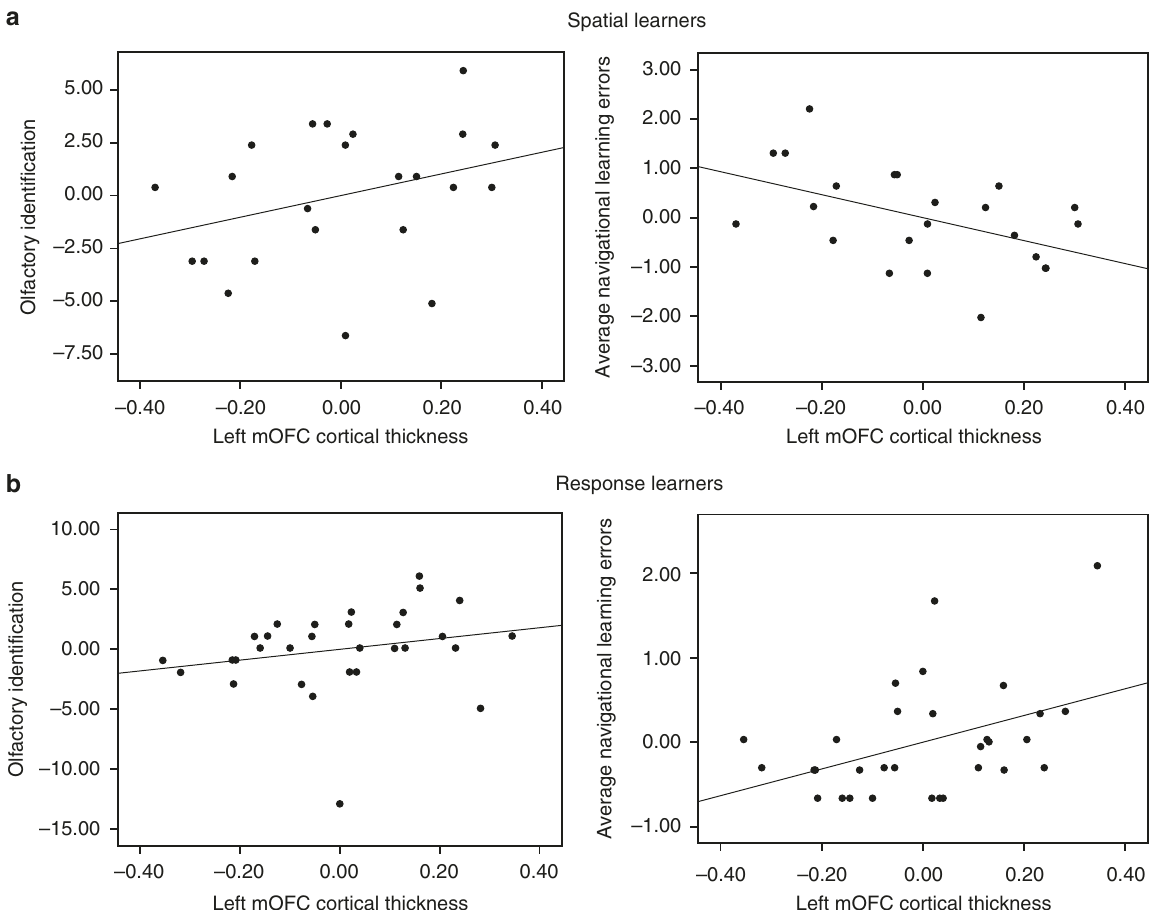
Fig. 3 Left medial orbitofrontal cortex (mOFC) cortical thickness correlates with both olfactory identi fi cation and spatial memory. a We measured mOFC cortical thickness using CIVET. Within spatial learners, left mOFC cortical thickness correlated positively with olfactory identi fi cation (left) ( r = 0.33, Bootstrap BCa 95% CI [0.02, 0.64]), and correlated negatively with average navigational learning errors (right) ( r = − 0.49, Bootstrap BCa 95% CI [ − 0.69, − 0.24]). b Within response learners, left mOFC cortical thickness did not correlate with olfactory identi fi cation (left) ( r = 0.23, Bootstrap BCa 95% CI [ − 0.07, 0.59]). Interestingly, it did correlate positively with average navigational learning errors (right) ( r = 0.42, Bootstrap BCa 95% CI [0.13, 0.67]), which indicates that the mOFC may interfere with stimulus-response learning. These results indicate that the relationship between